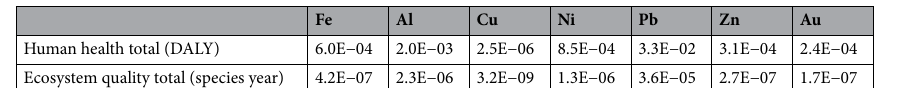
Table 7. Total endpoint environmental impact assessment of metal producing industries expressed in points/ US$1000 and excluding climate change impacts.